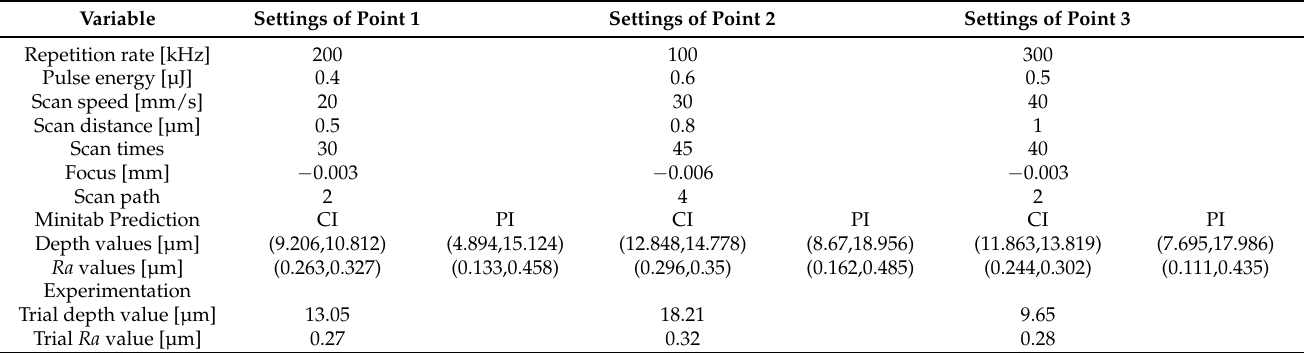
Table 5. Validation of prediction model based on comparison between experimental trial results, confidence, and prediction interval identified with